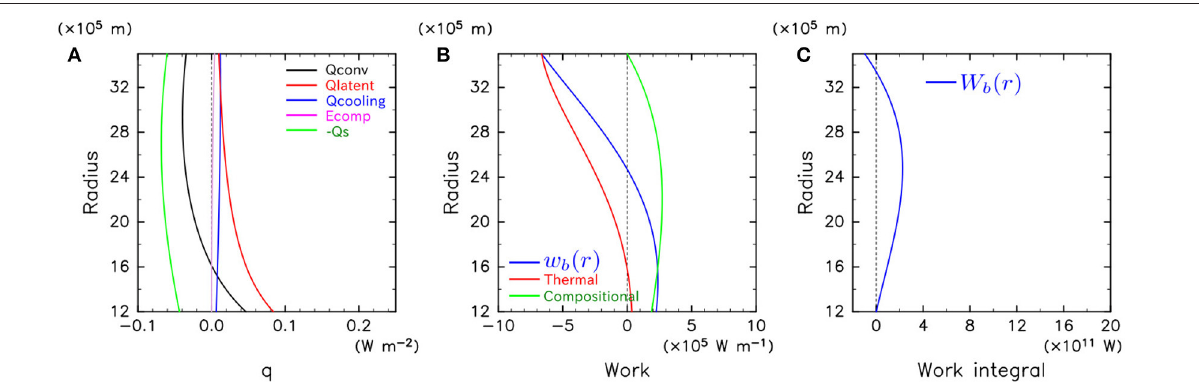
FIGURE 4 | As in Figure 2 but for Q CMB =